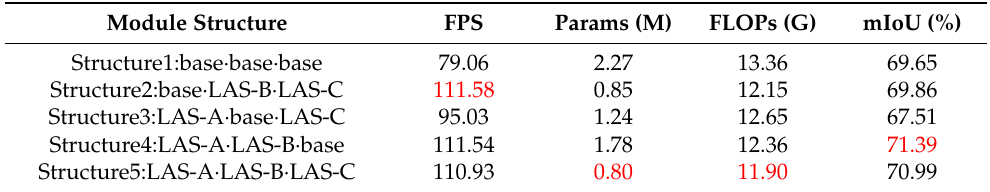
Table 4. Ablation studies of different module structures. The red color font indicates the optimal